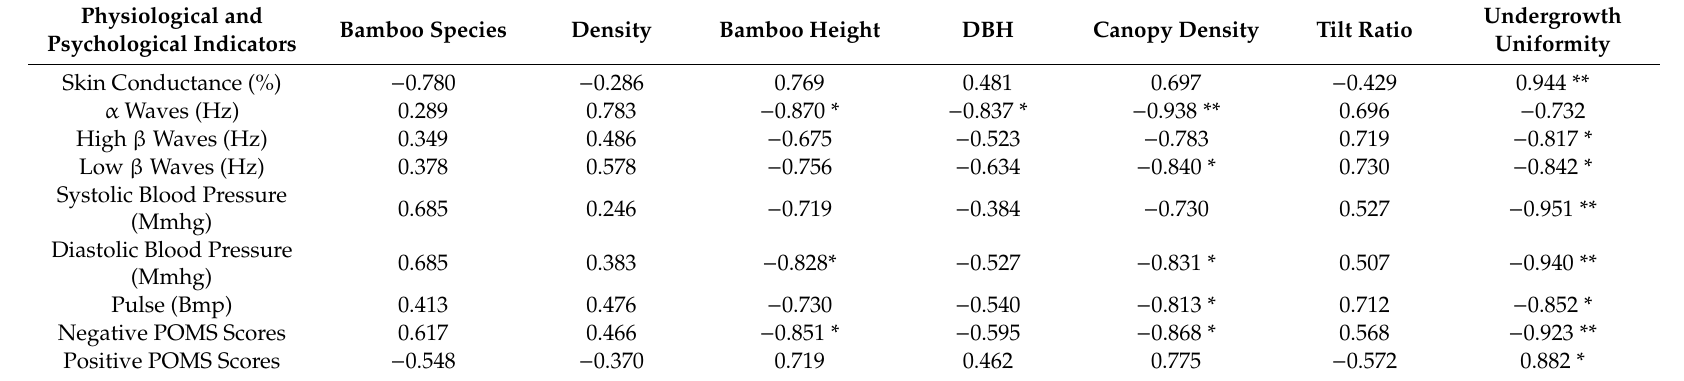
Table 3. Pearson’s correlation coe ffi cient between physiological and psychological indicators and the various landscape elements. Physiological